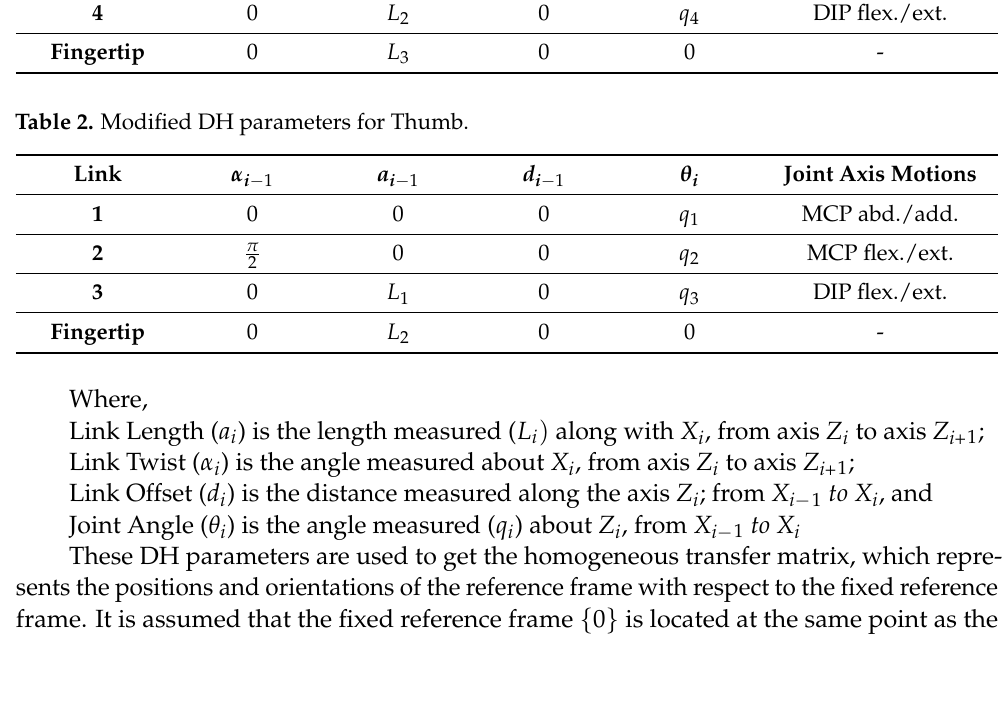
Table 2. Modified DH parameters for Thumb.